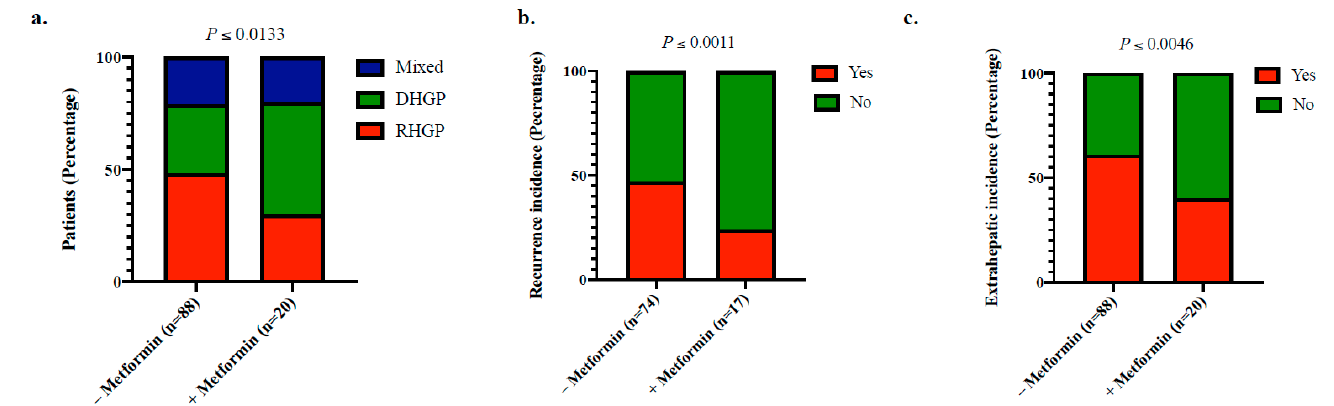
Figure 1. The effect of metformin on vessel co-option, recurrence, and extrahepatic metastases. ( a ) Represents the percentage of patients with vessel co ‐ option (RHGP), angiogenic (DHGP), or mixed (RHGP and DHGP) lesions according to the administration of metformin. ( b ) Represents the association between metformin administration by CRCLM patients and the development of recurrent tumours after hepatectomy. ( c ) Shows the correlation between the usage of metformin by CRCLM patients and the development of extrahepatic metastases after surgical resection. Chi-square test was used to compare the categorical variables.